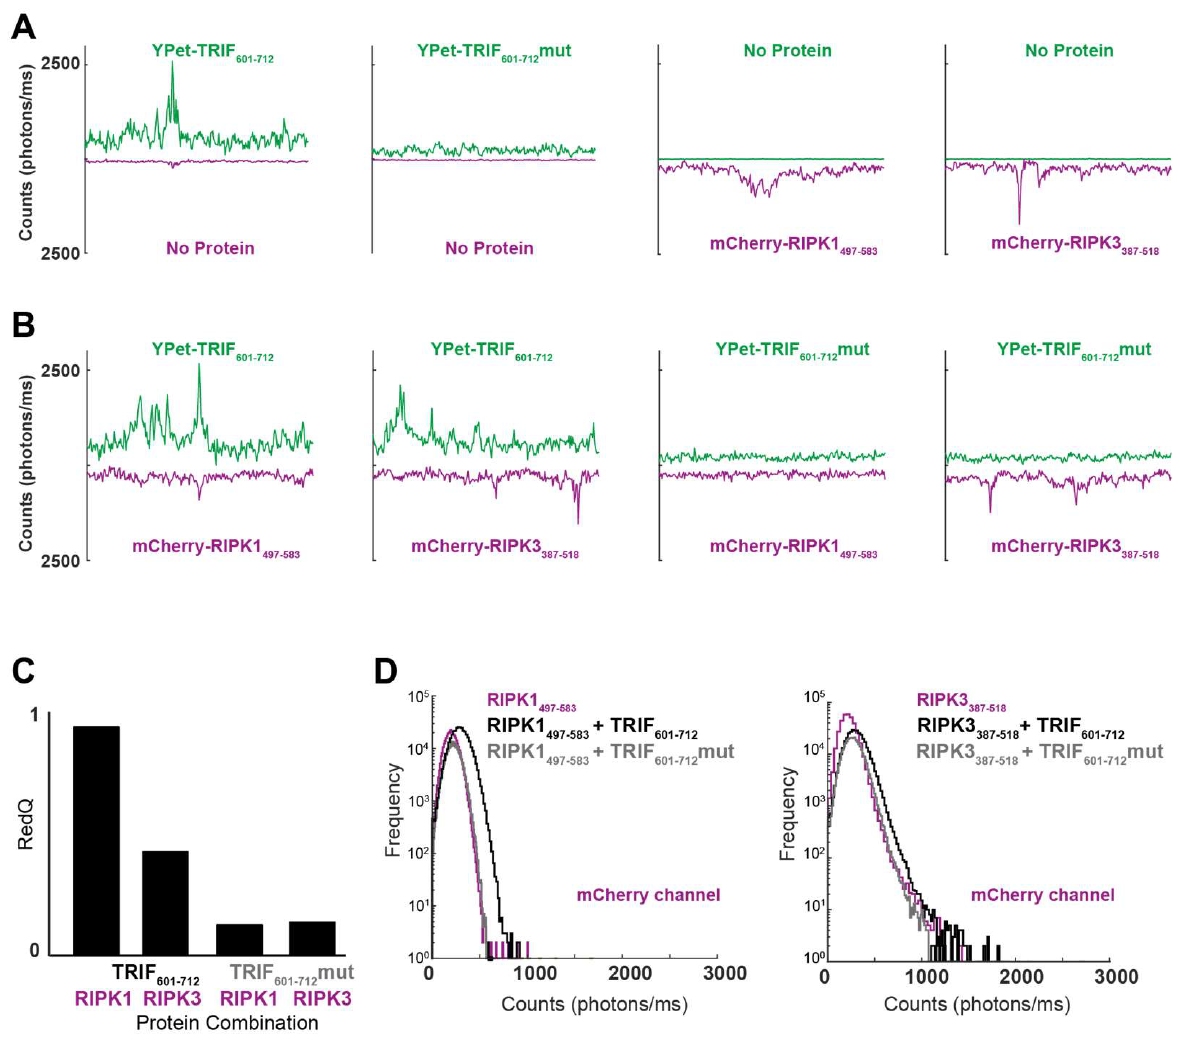
Figure 4. ( A ) Representative 250 ms time traces from individual RHIM-containing proteins at 0.175 µM under assembly-permissive conditions. YPet and mCherry fluorescence emission was measured simultaneously, allowing for detection of coincidence of different RHIM-containing proteins in individual assemblies diffusing through the confocal volume. Proteins in each sample are indicated on each trace. ( B ) Time traces from mixtures of RHIM-containing proteins: TRIF-RHIM 601–712 wt with RIPK1 497–583 and RIPK3 387–518 RHIMs, and TRIF-RHIM 601–712 mut with RIPK1 497–583 and RIPK3 387–518 RHIMs. ( C ) Comparison of RedQ scores of TRIF-RHIM 601–712 wt, TRIF-RHIM 601–712 mut, RIPK1 497–583 and RIPK3 387–518 RHIM combination pairs. ( D ) Photon count histograms from protein